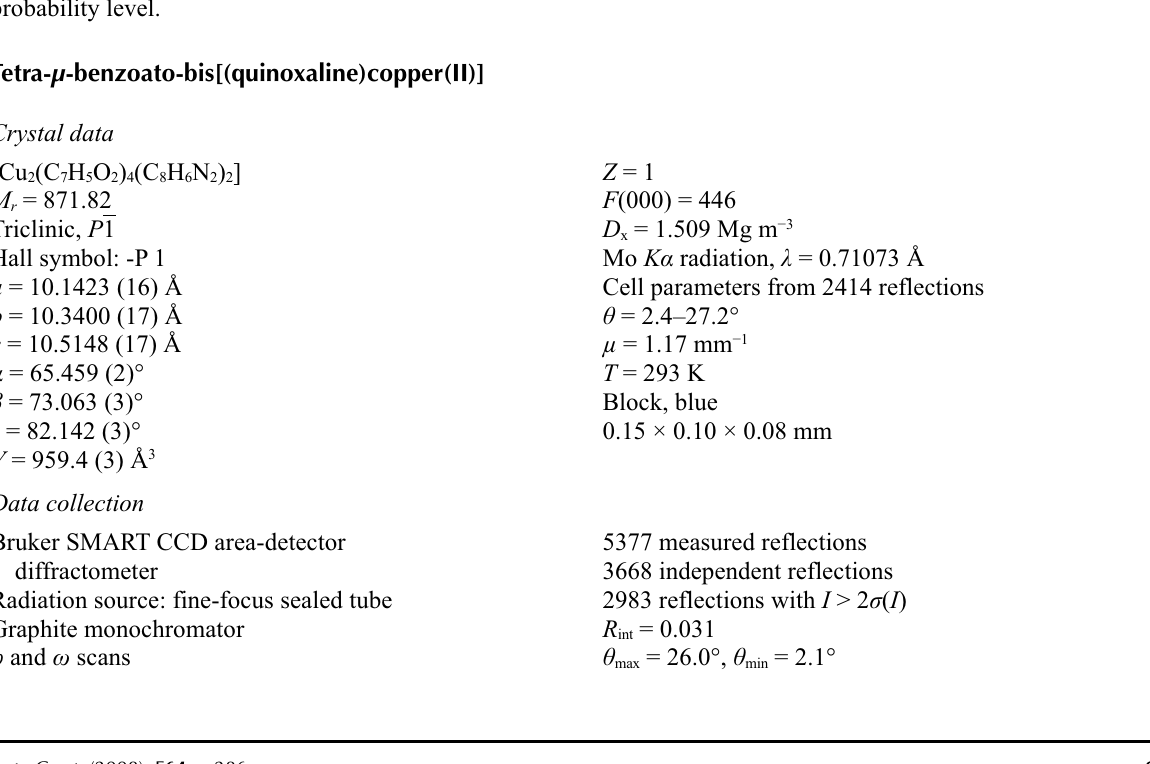
The structure of the title compound showing the atom-labeling scheme. Displacement ellipsoids are shown at the 30% probability